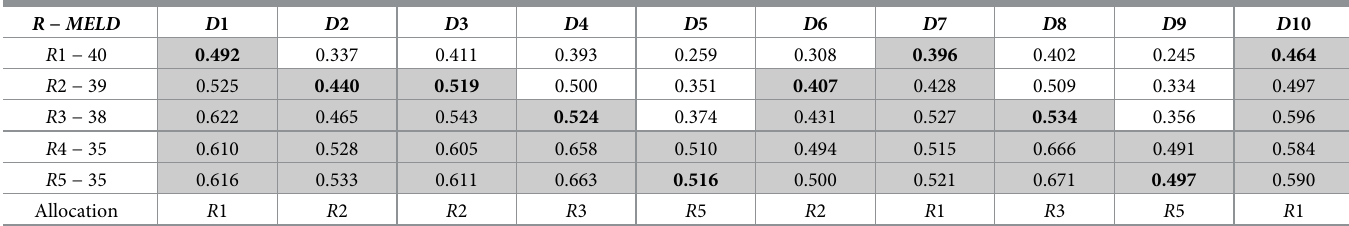
Table 7. Second simulation of D-R allocation by the best LR model (recipient MELDs 34 − 40).